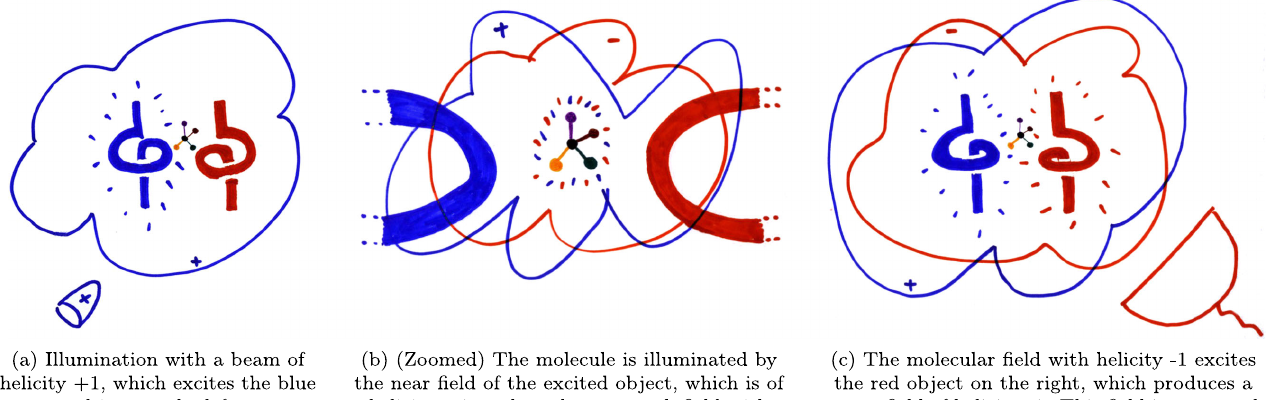
FIG. 3. Double resonant enhancement for circular dichroism measurements. Panel (a): Two resonant maximally electromagnetically chiral and reciprocal objects are placed close to each other. A chiral molecule is in their vicinity. The external illumination excites only one of the objects, whose resonance illuminates the molecule with a strong field of the same helicity as the incident beam. Panel (b): Upon illumination, the molecule produces a weak scattered field containing both helicities, which excite the two resonant objects. Panel (c): The scattered field of helicity opposite to the initial one is measured. This field exists because of the presence of the molecule. The other half of the circular dichroism measurement is obtained by interchanging the input and measured helicities. The final difference features the two resonant enhancements of opposite helicity: one in illumination and one in the amplification of the field scattered by the